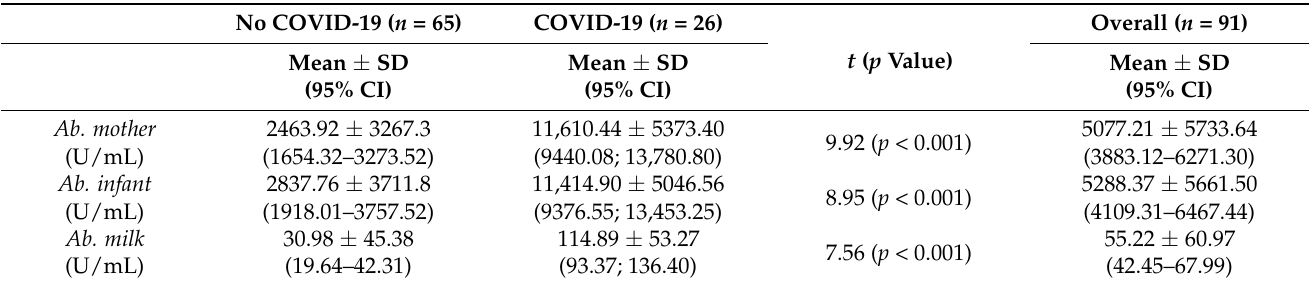
Table 1. Descriptive statistics of the cohort of